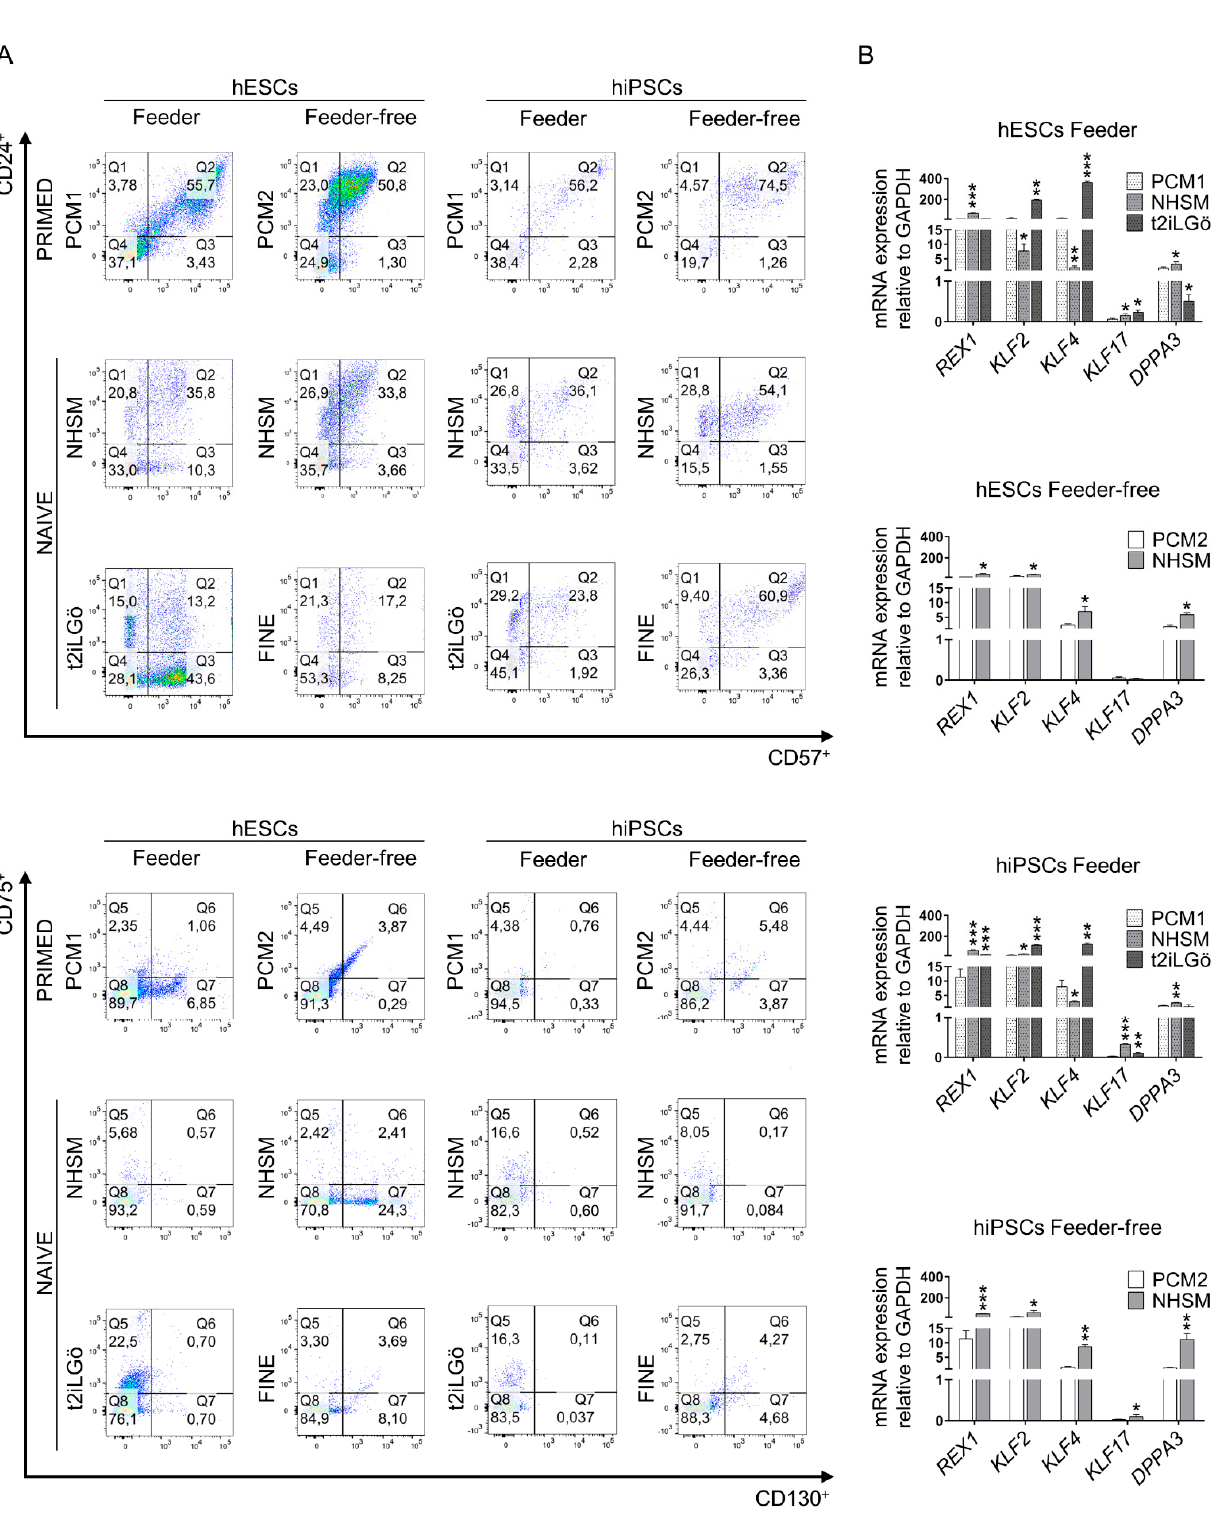
Figure 2. Evaluation of naive conversion of primed hPSCs (hESCs, hiPSCs) in different culture media conditions. ( A ) Flow cytometry analysis of primed status specific markers (CD24 and CD57) and naive status specific markers (CD75 and CD130) on feeder and feeder-free hPSCs cultures. ( B ) Gene expression analysis for naive identity specific genes ( REX1 , KLF2 , KLF4 , KLF17 and DPPA3 ) on feeder and feeder-free hPSCs cultures. All comparisons are relative to primed media (* p < 0.1, ** p < 0.01 and *** p < 0.001). Data are represented as mean ± SD.